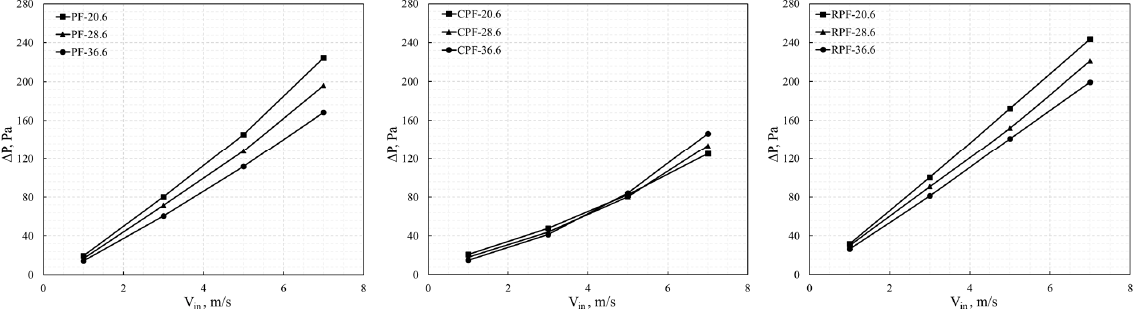
Figure 9. Pressure drops across three different types of heat sinks with different inlet velocities of flue gas. ( T in = 600 °C).